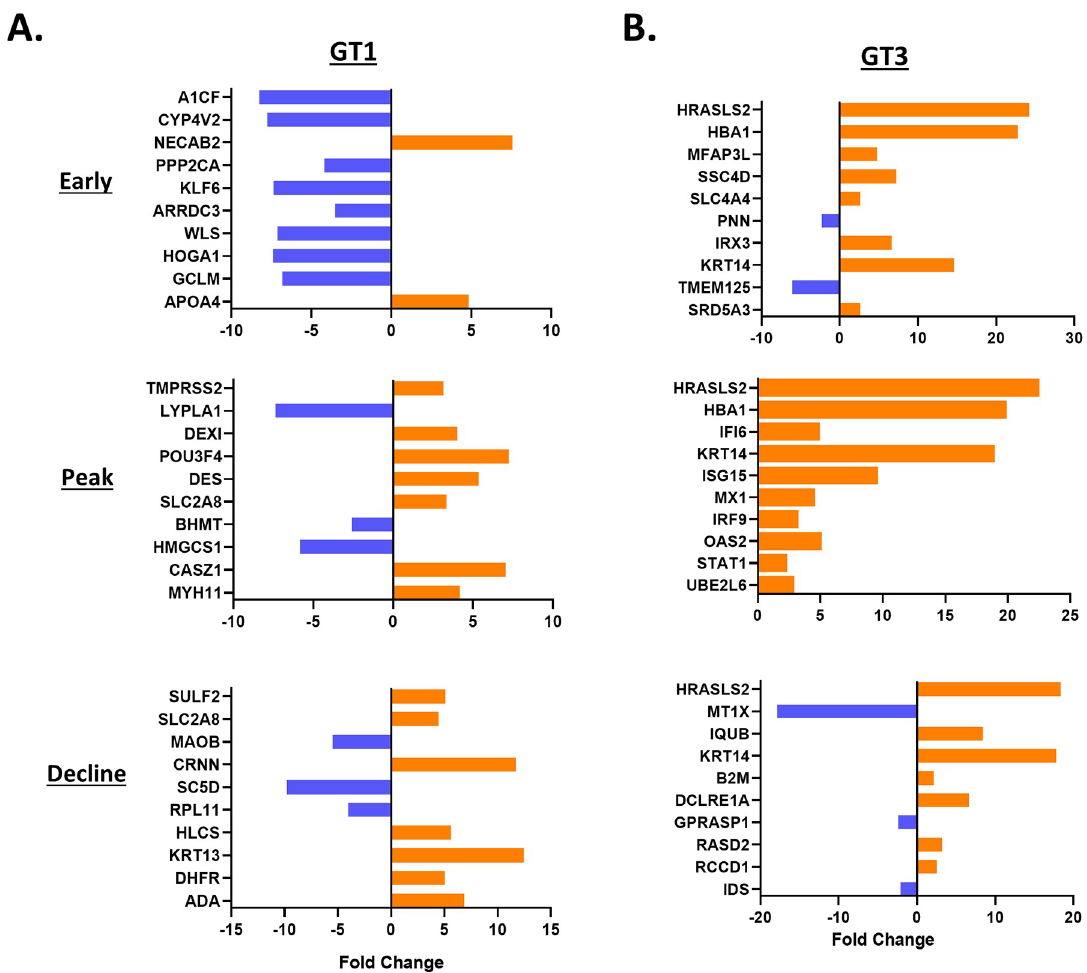
Fig 5. Longitudinal differential gene expression analysis during HEV gt1/gt3 infection. Top upstream 10 pathways predicted to be involved in HEV gt1 (A) and gt3 (B) infection. Functional classification and pathways are ranked by the negative log of the p-value of the enrichment score. Th significantly regulated genes ranked by the p-value and fold changes and identified with enrichment scores > 1.3 with a p-value cutoff of > 0.05.